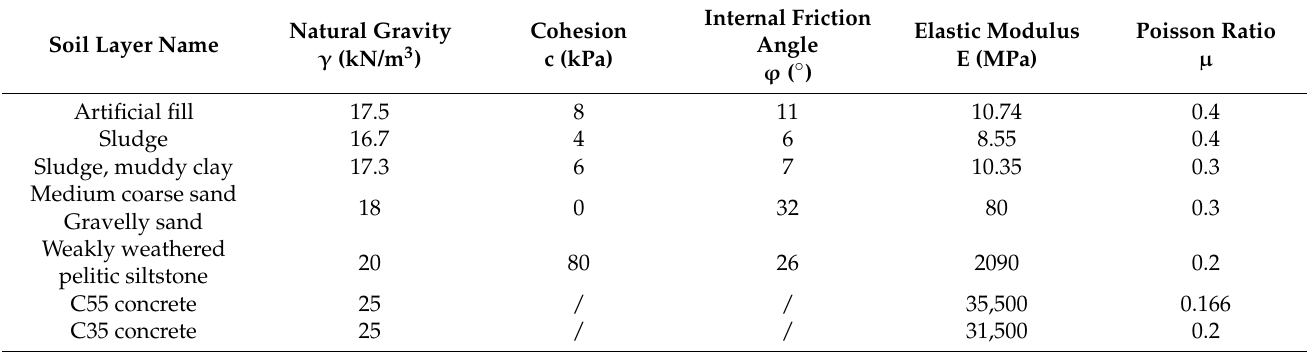
Table 3. Physical and mechanical parameters.